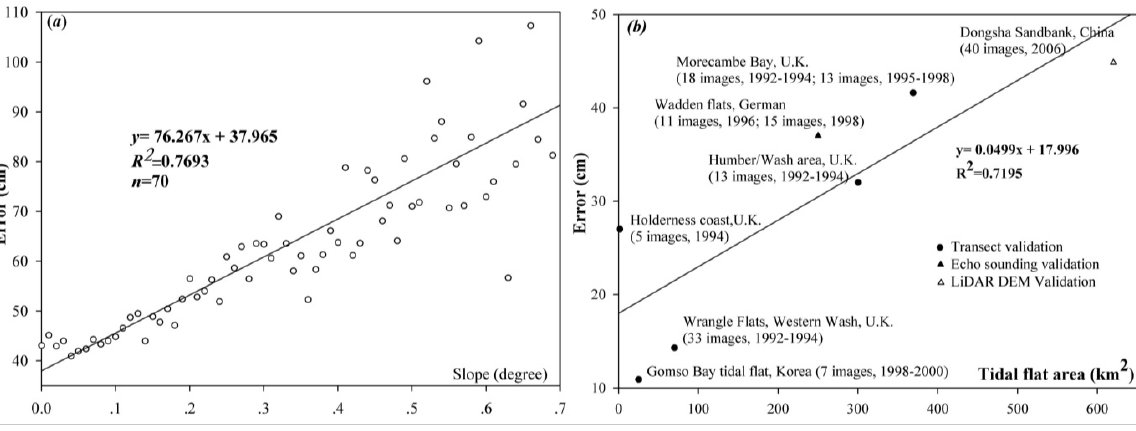
Figure 6. ( a ) Relationship between the error of the resultant DEMs and the slope of the tidal flat; ( b ) relationship between the area of the tidal flat and the accuracy of the resultant